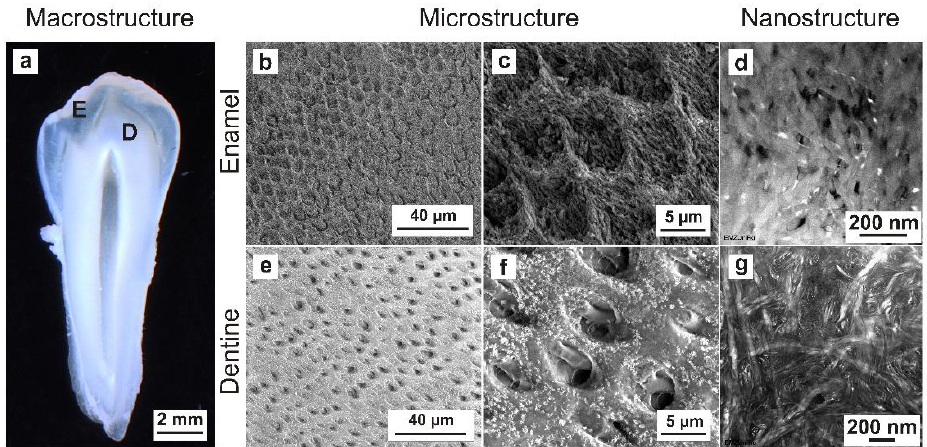
Figure 1. The structural hierarchy of mature human enamel and dentine from the macroscale to nanoscale. ( a ) Stereo-zoom microscopy of a tooth slice from a premolar; thickness, 1 mm; view from mesial, (E) enamel and (D) dentine. ( b ) SEM micrograph of enamel. The alternating orientation of the prism rods (level 6) reveals the Hunter – Schreger bands (level 7). ( c ) SEM micrograph of enamel showing interprisms and prisms (level 5) formed by hydroxyapatite crystallite nanofibrils (level 2 – 4). ( d ) TEM micrograph of enamel showing hydroxyapatite crystallites (level 1). ( e ) SEM micrograph showing numerous dentinal tubules, peritubular dentine and intertubular dentine. ( f ) SEM micrograph illustrating dentinal tubules and odontoblast processes. ( g ) TEM micrograph of the nanostructure of intertubular dentine.